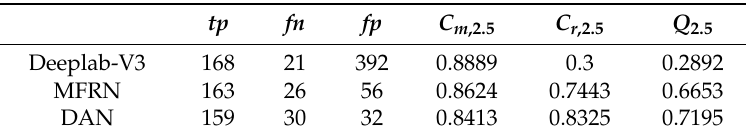
Table 4. Object-based evaluation results of the proposed network with other networks on Potsdam datasets using the completeness, C m ; correctness, C r ; quality metrics, Q ; ( C m ,2.5 , C r, 2.5 , and Q 2.5 are for buildings over 2.5 m 2 ). tp fn fp C m ,2.5 C r